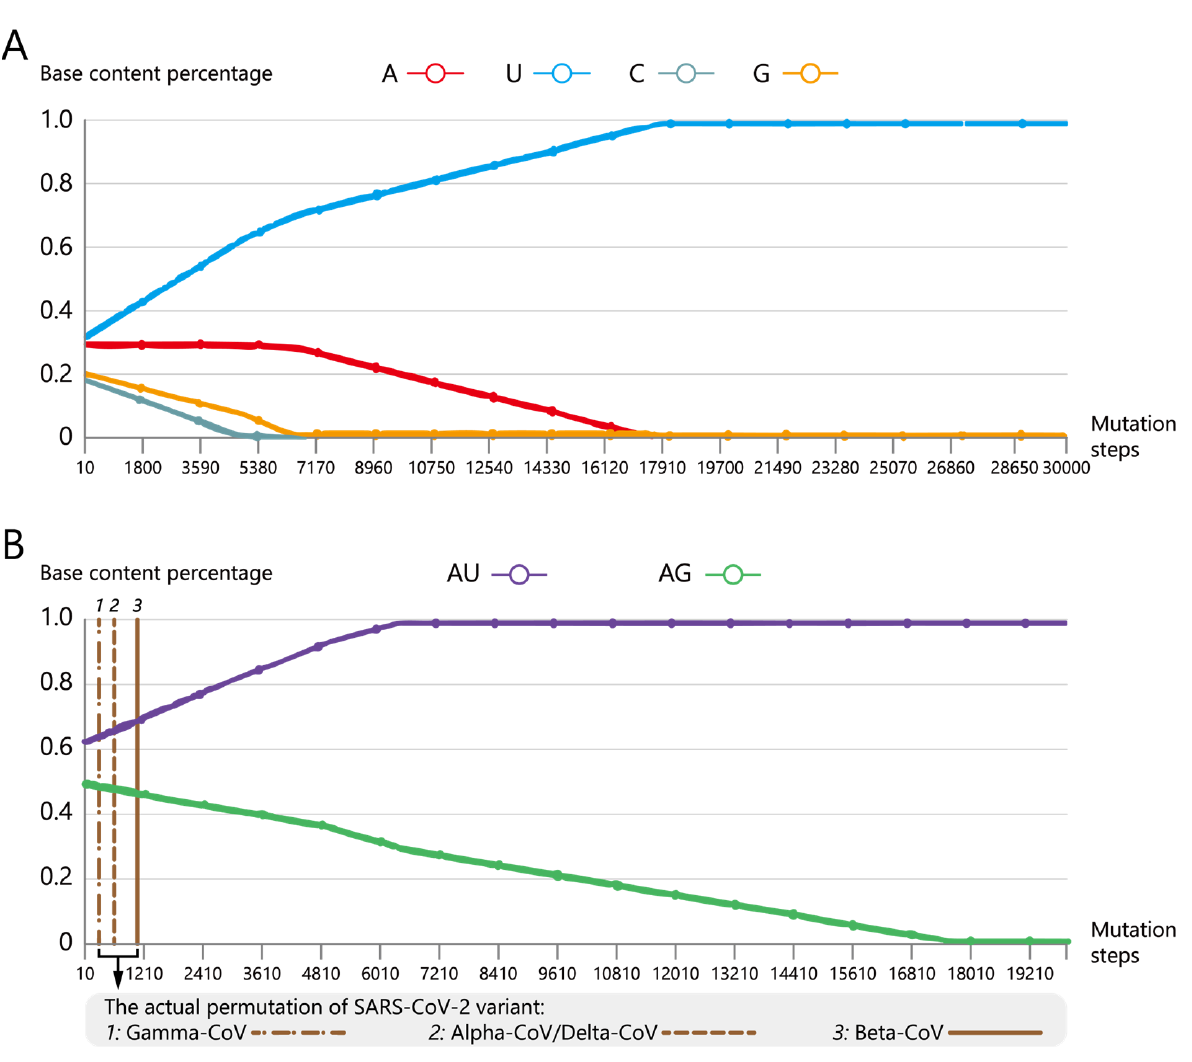
Figure 6. Variation of base content percentage in mutation simulation. ( A ) The percentage of four base content during mutation simulation. The horizontal axis represents the cumulative mutation number and the vertical axis represents the base percentage. Red, blue, dark green and orange lines represent the content percentage of A, U, C and G, respectively. ( B ) The percentage of “AG” and “AU” content during the mutation simulation. Brown dotted lines represent how many mutation steps that the percentage of “AG” and “AU” content would deviate from the base content percentage of Gamma-CoV, Alpha-CoV/Delta-CoV and Beta-CoV, respectively. Purple and light green lines represent the percentage of “AG” and “AU” content, respectively.